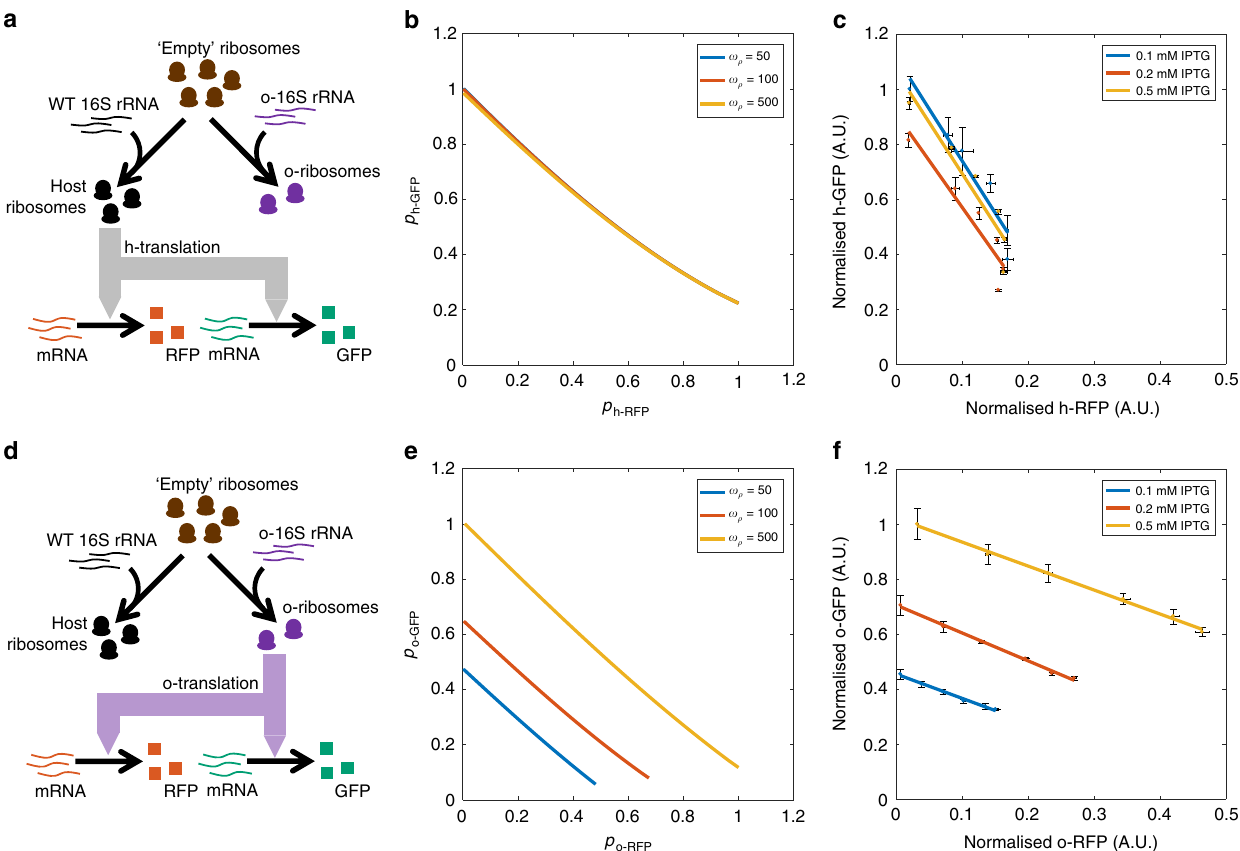
Fig. 2 Gene coupling in gene circuits utilising either the host or orthogonal ribosome pool. Simulations of the steady-state concentrations of RFP and GFP normalised by the maximum protein production achieved across the o-rRNA transcription rates tested. ω GFP = 100 and ω RFP = 1 to 10 3 mRNAs per min. o- rRNA production ( ω ρ ) was simulated at the RNAs per min as shown. Experimental data was produced by inducing RFP using AHL from 0 to 20 nM. Points are the mean steady-state fl uorescence ± 1 SD normalised by maximum GFP expression obtained across different levels of IPTG treatment. N = 3. Raw data is shown in Supplementary Fig. 8 The isocost line is fi t to the mean fl uorescence as determined by FACS from cultures during mid-exponential growth (between 3 and 5 h post-induction dependent on the strain and circuit) and the gradient shown in Supplementary Fig. 9. o-ribosome production was induced using three different IPTG concentrations 0.1, 0.2 and 0.5 mM as shown. a Allocation of ribosomes in panels b and c where both circuit genes share the host ribosome pool. b Simulations of circuit using the host ribosome pool. c In vivo protein productions of circuit proteins using the host ribosome pool. FACS pro fi les shown in Supplementary Fig. 10. d Allocation of ribosomes in panels e and f where both circuit genes share the o-ribosome pool. e Simulations of the circuit using the o-ribosome pool for translation. f In vivo coupling observed in the circuit using the o-ribosome pool. FACS pro fi les are shown in Supplementary Fig.